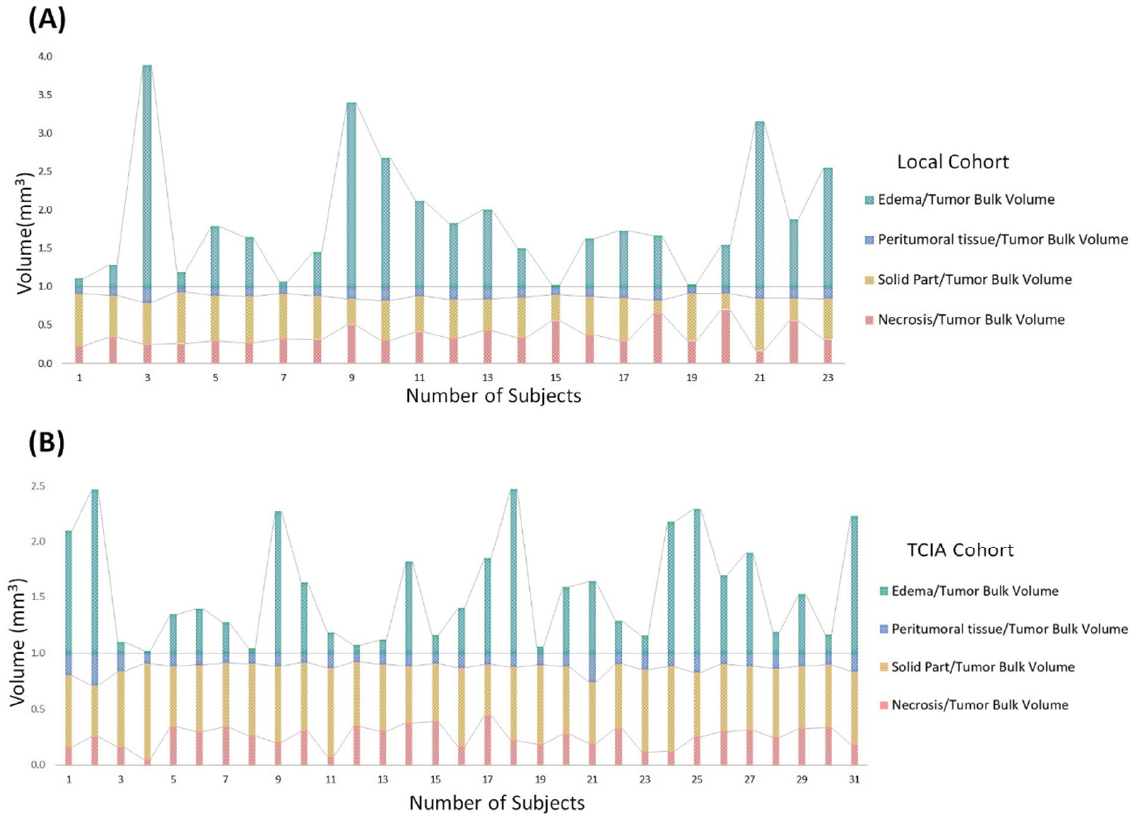
Figure 3. Stacked column chart reveals the size distribution of volumetric tumor features across subregions of GBM in ( A ) local and ( B ) TCIA cohort. Compared to the tumor bulk volume, edema had the largest median size across all subregions. Solid part tumor and peritumoral tissue showed more consistent areas than other regions. Size variation of volumetric feature areas other than edema was generally low across subregions.